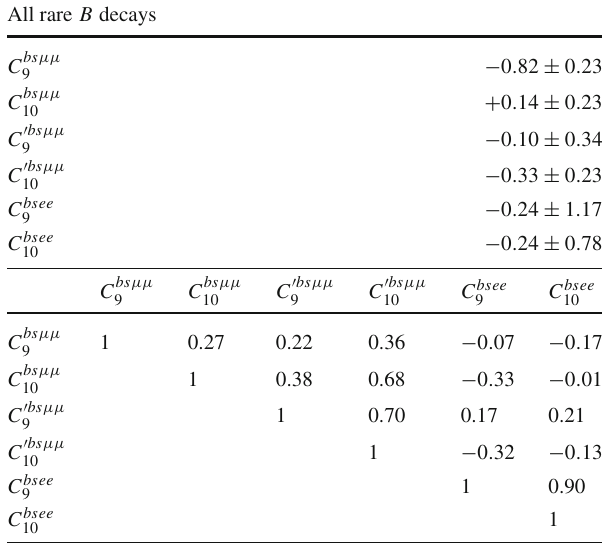
Table 5 Best fit values, uncertainties, and correlation matrix of the six- μμ parameter fit to the Wilson coefficients C bs 9